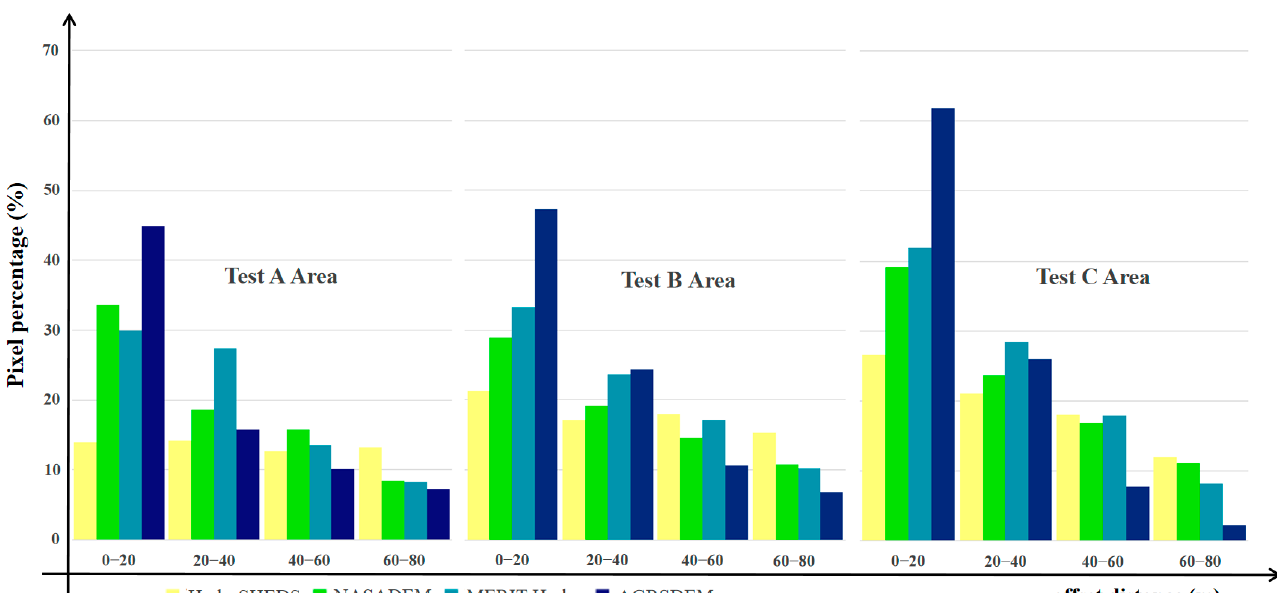
Figure 9. Histogram of river network extraction of four DEMs in the three test areas.